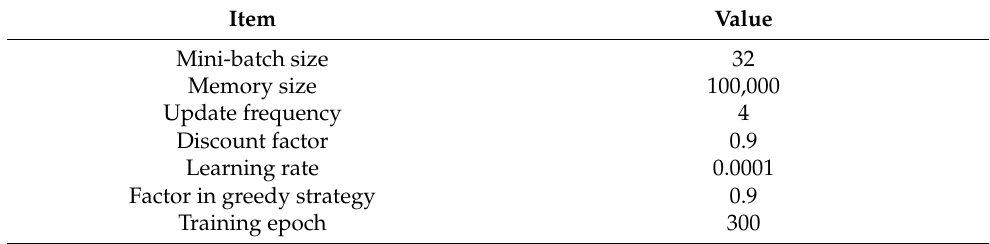
Table 2. Hyperparameters of the DQN framework.